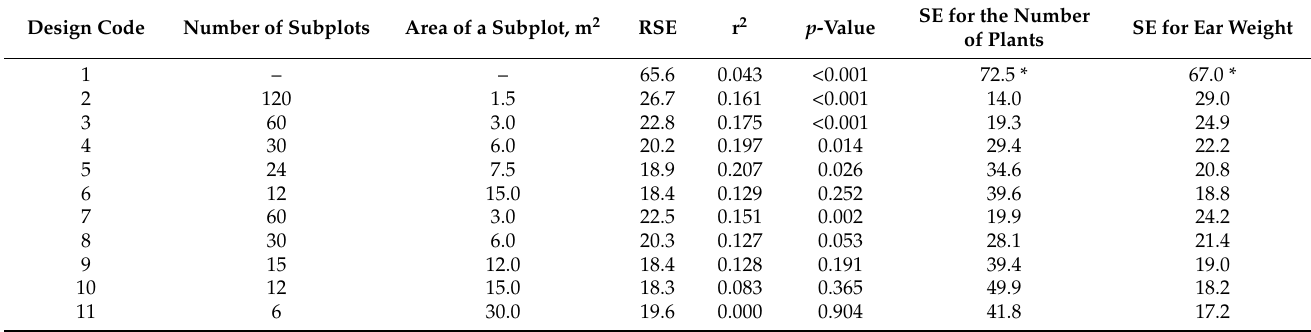
RSE: residual standard error, r 2 : determination coefficient, SE: standard error. * given for the plant- to-plant distance (cm) and the ear weight for an individual plant (g).